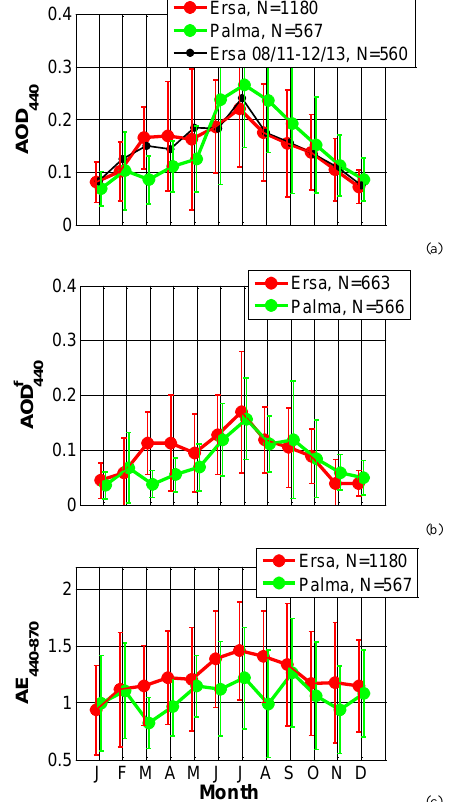
Figure 6. Monthly average variations calculated with daily mea- surements of (a) aerosol optical depth at 440nm (AOD 440 ) , (b) fine-mode aerosol optical depth at 440nm (AOD f (c) the Ångström exponent calculated between 440 and 870nm (AE 440 − 870 ) derived from AERONET level 2.0 inversion products available for the period 2011–2015. The error bars represent the standard deviation. On the AOD 440 plot we have also plotted the monthly values at Ersa calculated over the limited period for which data are also available at Palma, i.e., August 2011–December 2013.